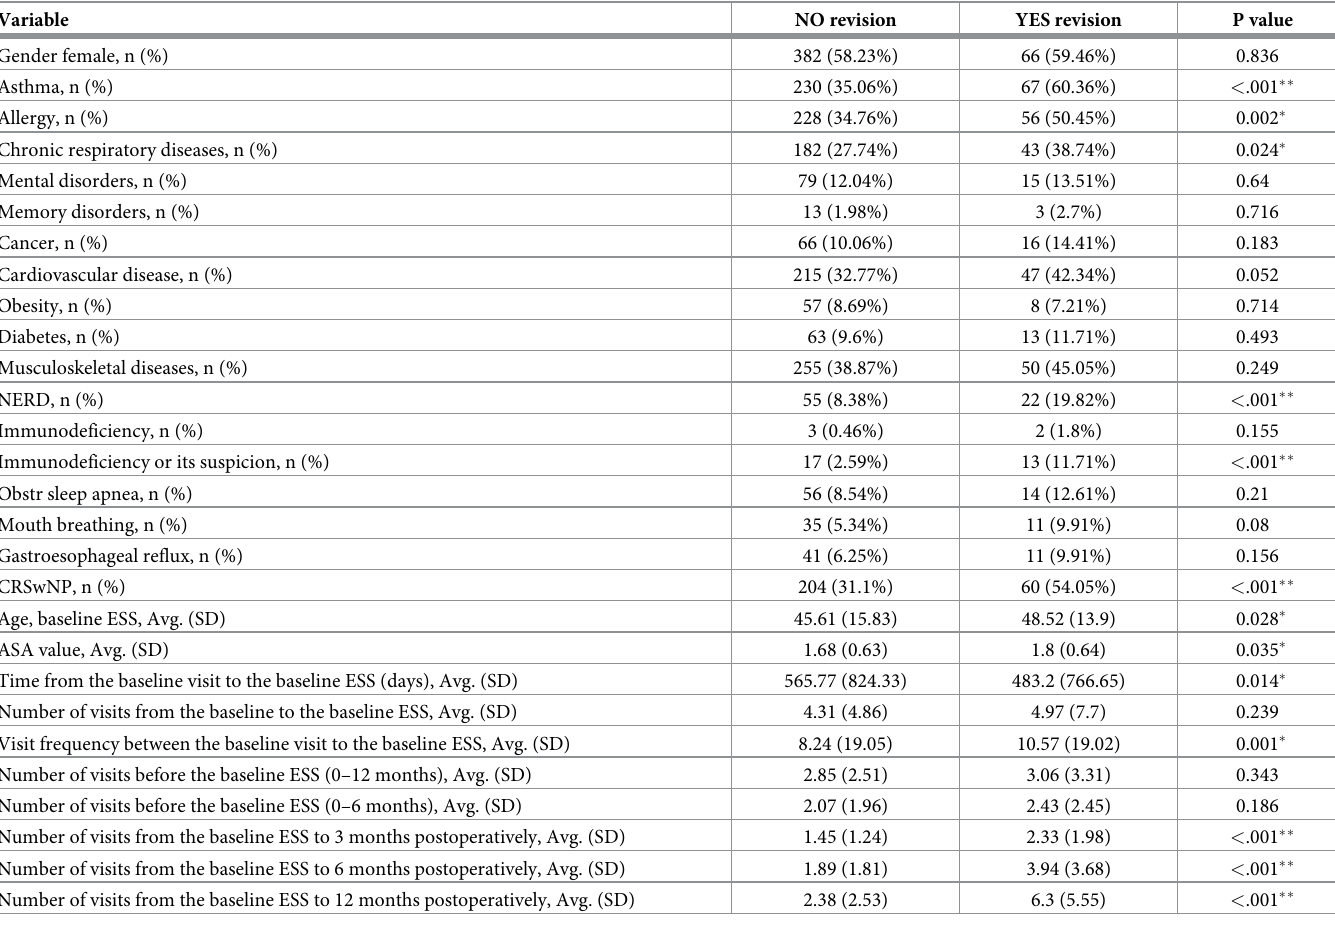
Table 2. Characteristics of patients without and with the revision ESS. P values calculated using the Fisher’s exact or Mann-Whitney U